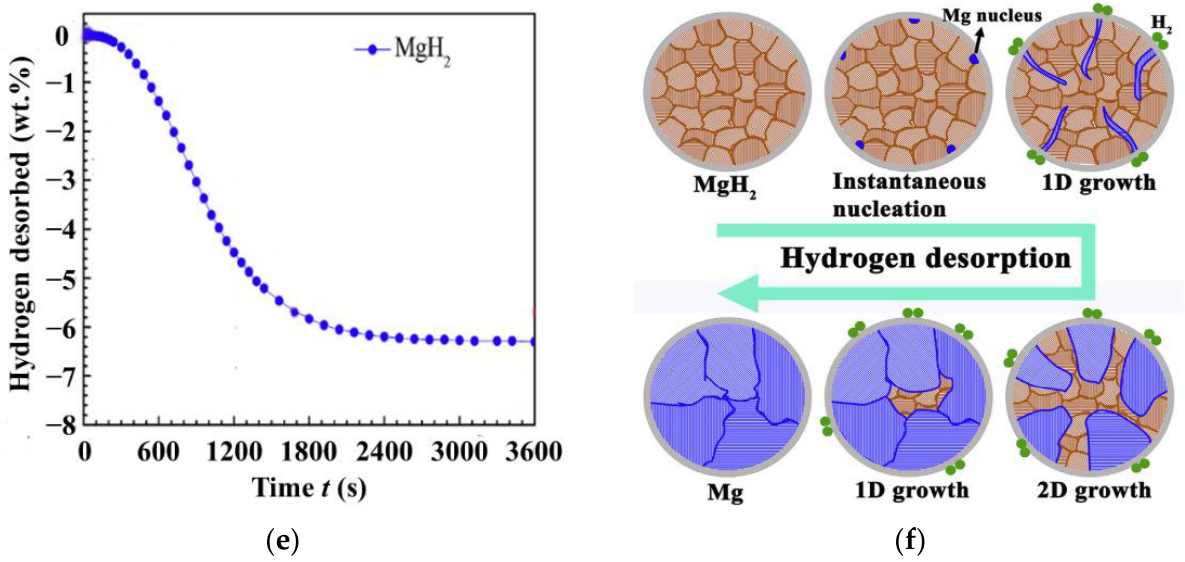
Figure 4. ( a ) TEM images for the partially dehydrogenated MgH 2 samples [46]; ( b ) corresponding SAED patterns of ( a ) [46]; ( c ) TEM images for the entirely dehydrogenated MgH 2 samples [46]; ( d ) corresponding SAED patterns of ( c ) [46]; ( e ) Isothermal dehydrogenation curves of MgH 2 samples at 623 K [46]; ( f ) Schematic illustration of the growth mechanism of Mg crystallites during hydrogen desorption of MgH 2 [46].